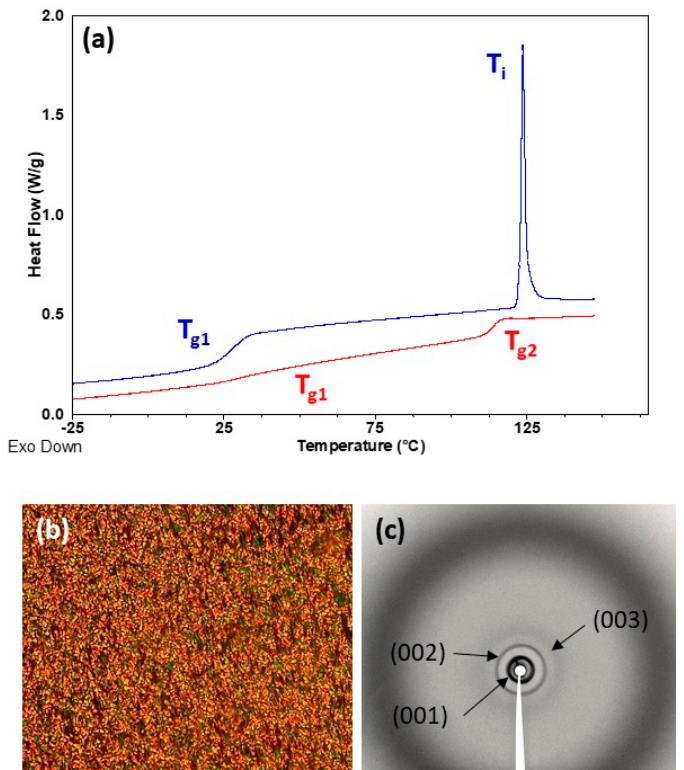
Figure 4. ( a ) DSC curves of P 100 (7eAZO/eAZO) (upper blue curve) and P 40 (7eAZO/eAZO)- b - PMMA 800 (lower red curve) registered during the second heating scan at 20 °C min –1 . ( b ) POM photograph of P 100 (7eAZO/eAZO) taken at 145 °C on cooling from isotropic liquid. ( c ) XRD difractogram of P 100 (7eAZO/eAZO) registered at room temperature after annealing at 100 °C.